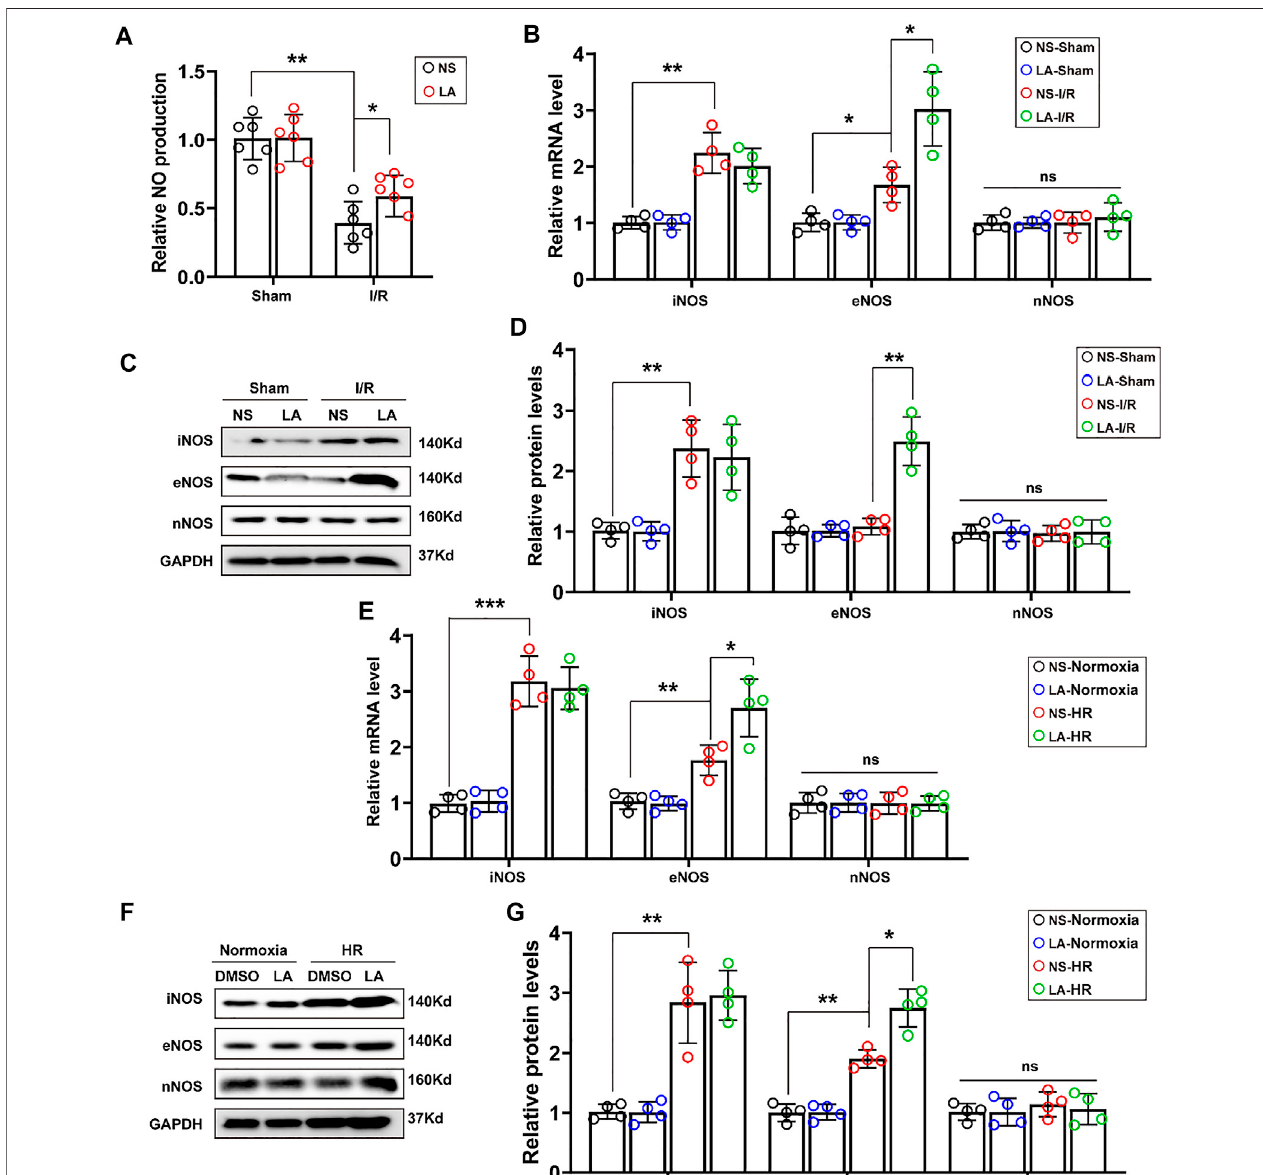
FIGURE 5 | LA promotes expression of eNOS in vivo and in vitro (A) . NO production in the indicated groups 24 h post-MI/R operation ( n (cid:1) 6) (B) . The mRNA expression levels of iNOS, eNOS and nNOS in the indicated groups 24 h post-MI/R operation ( n (cid:1) 4). Normalized to GAPHD (C,D) . Representative western blot and analysis of iNOS, eNOS and nNOS in hearts following MI/R or sham, normalized to GAPDH ( n (cid:1) 4) (E) . The mRNA expression levels of iNOS, eNOS and nNOS in LA or DMSO pretreated H9C2 cells with or without HR (F,G) . Representative western blot and analysis of iNOS, eNOS and nNOS in H9C2 cells, normalized to GAPDH ( n (cid:1) 4). Dataarepresentedasthemean ± SEM,witheach point representing amouse or acellsample. *indicates p < 0.05, **indicates p < 0.01, *** indicates p < 0.001, ns indicated no signi fi cance.